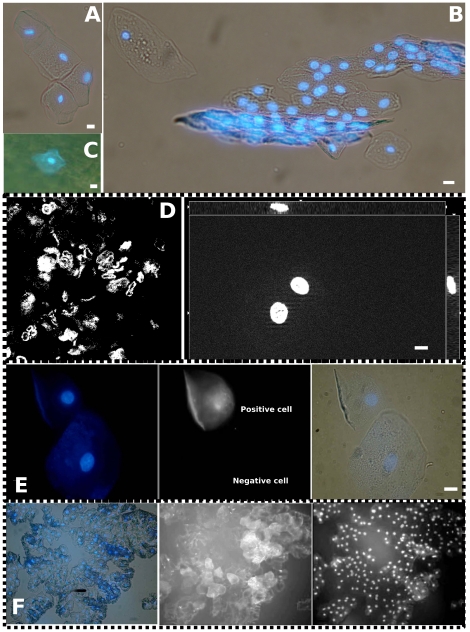
Morphology of H+/K+ ATPase-positive cells from preterm infants, freshly isolated and in primary cultures.A. B. Typical freshly isolated exfoliated cells from Day-5 to Day-36. C. Epithelial cell adherent to external wall of nasogastric tube. D. Samples obtained before Day-5 were mostly made up of cellular aggregates showing damaged nuclei (left insert). Later, all preparations contained epithelial cells showing quiescent nuclei (right insert). E. Pouf5-F1-Oct-4 positive and negative cells at inoculation for primary culture (center panel), nuclei are shown on left panel and nuclei inside cytoplasm shown on right panel. F. A colony of growing epithelial cells harboring Pouf5-F1-Oct-4 biomarker of progenitor status (center panel). Nuclei inside cytoplasm shown on left panel and nuclei staining by Hoechst on right panel. White bars stand for 10 µm.